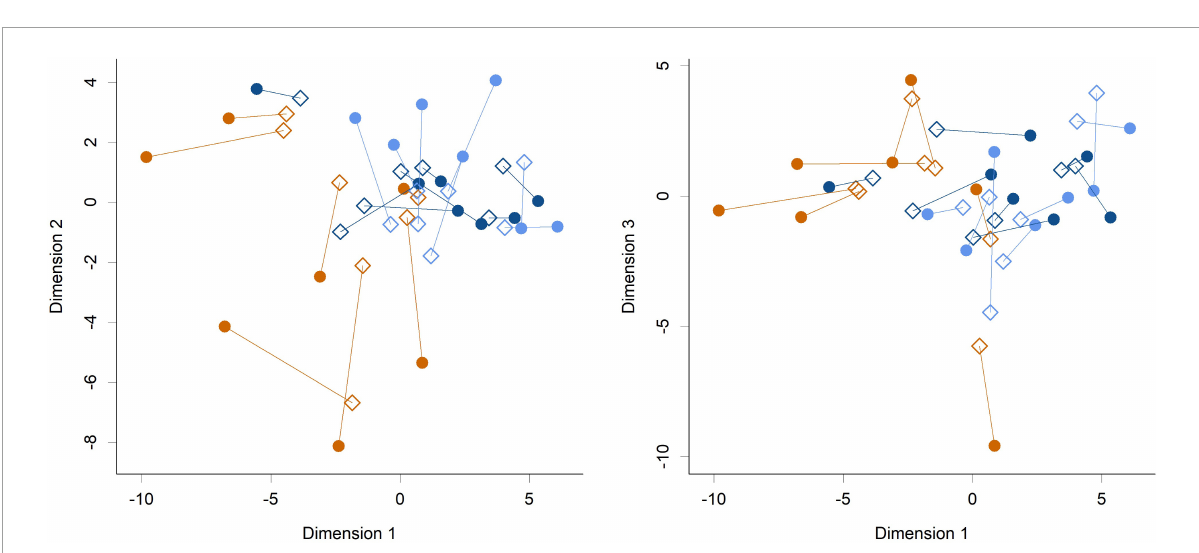
FIGURE4 Procrustes rotation analysis of the cecal (circles) and fecal (diamonds) communities at the genus level (Dimension 1 vs. Dimension 2 and Dimension 1 vs. Dimension 3 shown). Colors indicate groups; Control (orange), HN001 Low (light blue), HN001 High (dark blue). Lines join fecal and cecal communities from the same piglet. Procrustes symmetric rotation correlation = 0.704 ( P <